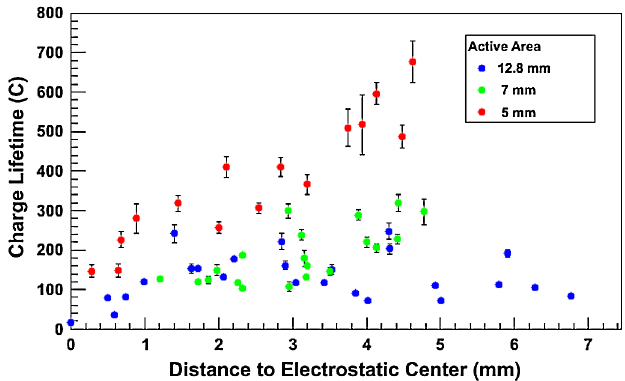
FIG. 8. The photocathode charge lifetime versus radial posi- tion of the drive laser beam relative to the photocathode electro- static center and as a function of photocathode active area diameter: 5, 7 and 12.8 mm. The size of the error bar is related to the quality of the exponential fit to the photocathode QE decay. The best exponential fits (and smallest error bars) were obtained when QE decayed quickly, with charge extracted comparable to the charge lifetime.